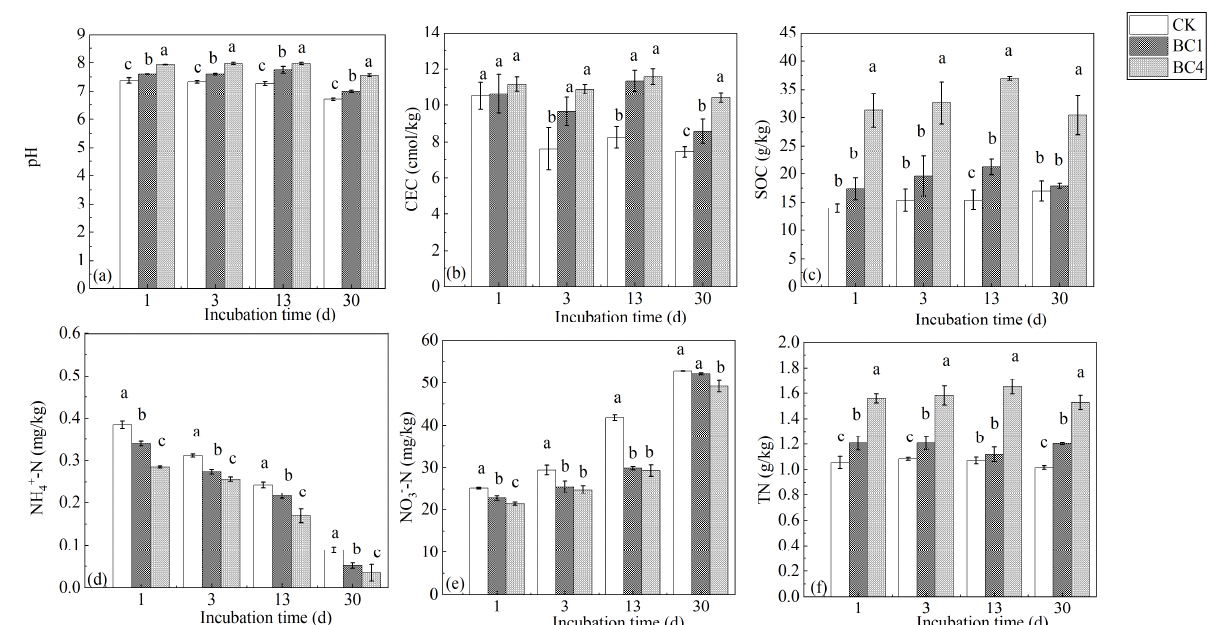
Figure 1. The effects of biochar addition on soil ( a ) pH, ( b ) CEC, ( c ) SOC, ( d ) NH 4+ -N, ( e ) NO 3 − -N and ( f ) TN during the 30-day incubation. Different letters indicate significant variations among treatments at the same incubation time at p < 0.05. Vertical bars indicate the standard error of the mean (n = 3).